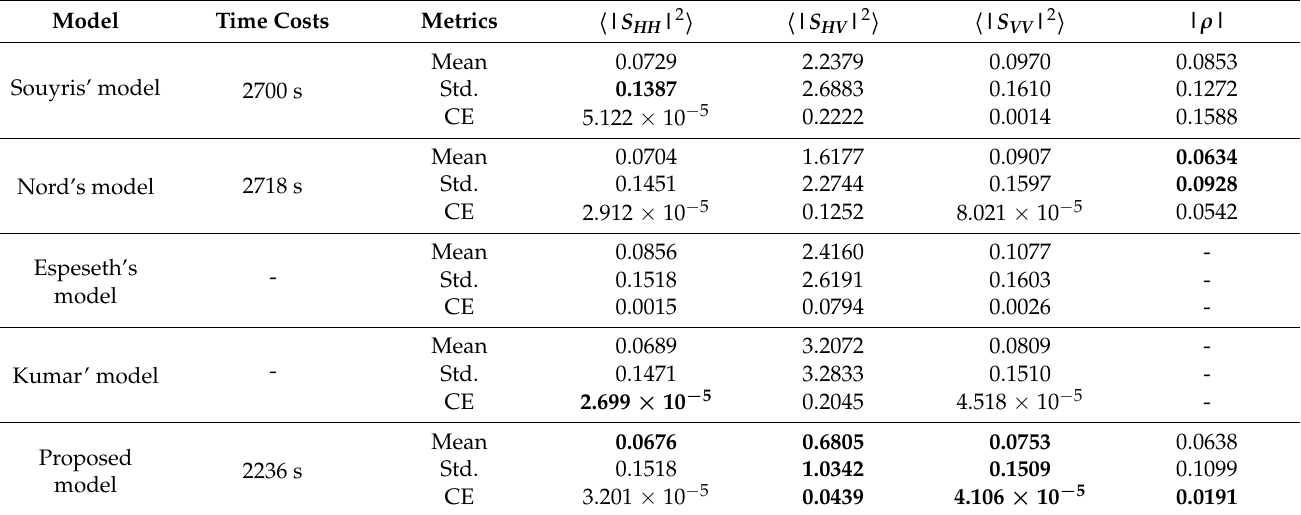
Table 2. Quantitative analysis of the parameters reconstructed using different models on Gaofen-3